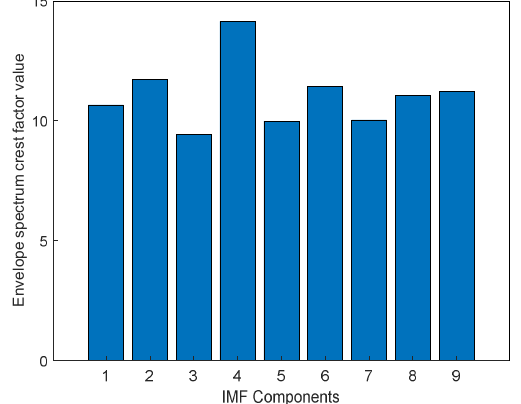
Figure 6. Each component’s envelope spectrum crest factor value.